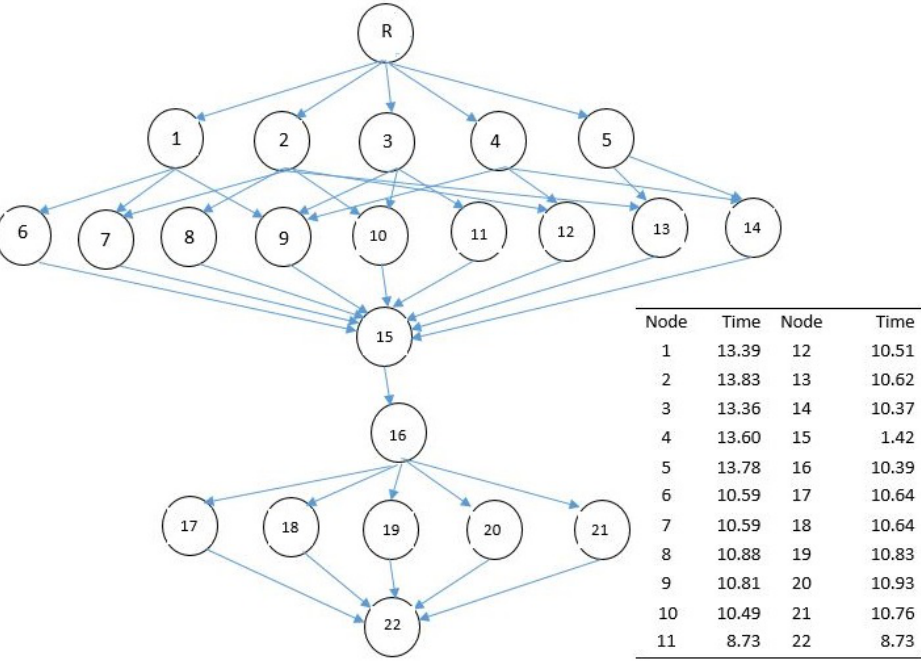
Figure 9. Montage Workflow for Dataset File